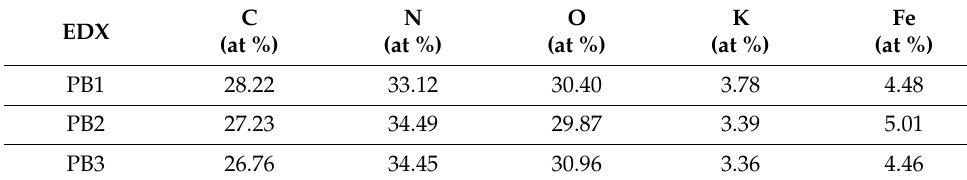
Table 2. The normalized data regarding the EDX spectra of the PB films of Figure 3.